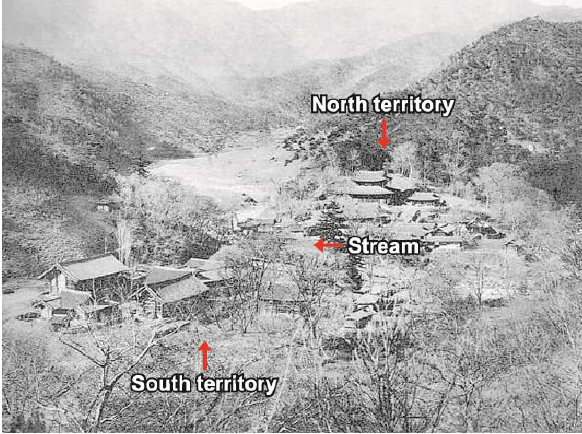
Figure 1. Magoksa Temple in the 1920s, as documented in